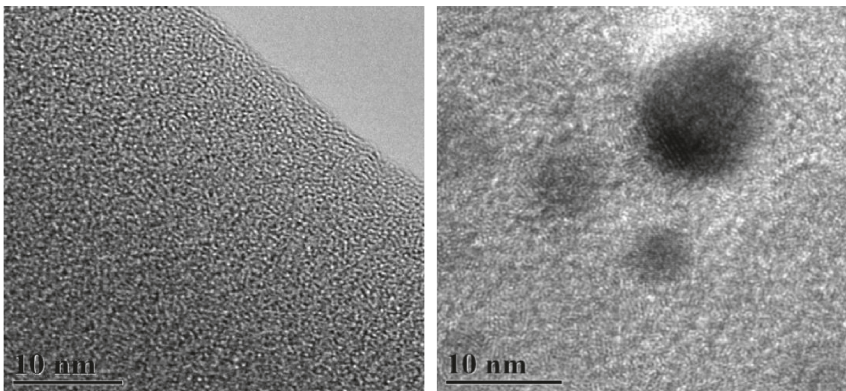
Figure 5: TEM images of pure (a) β -CD and (b) Cu- β -CD